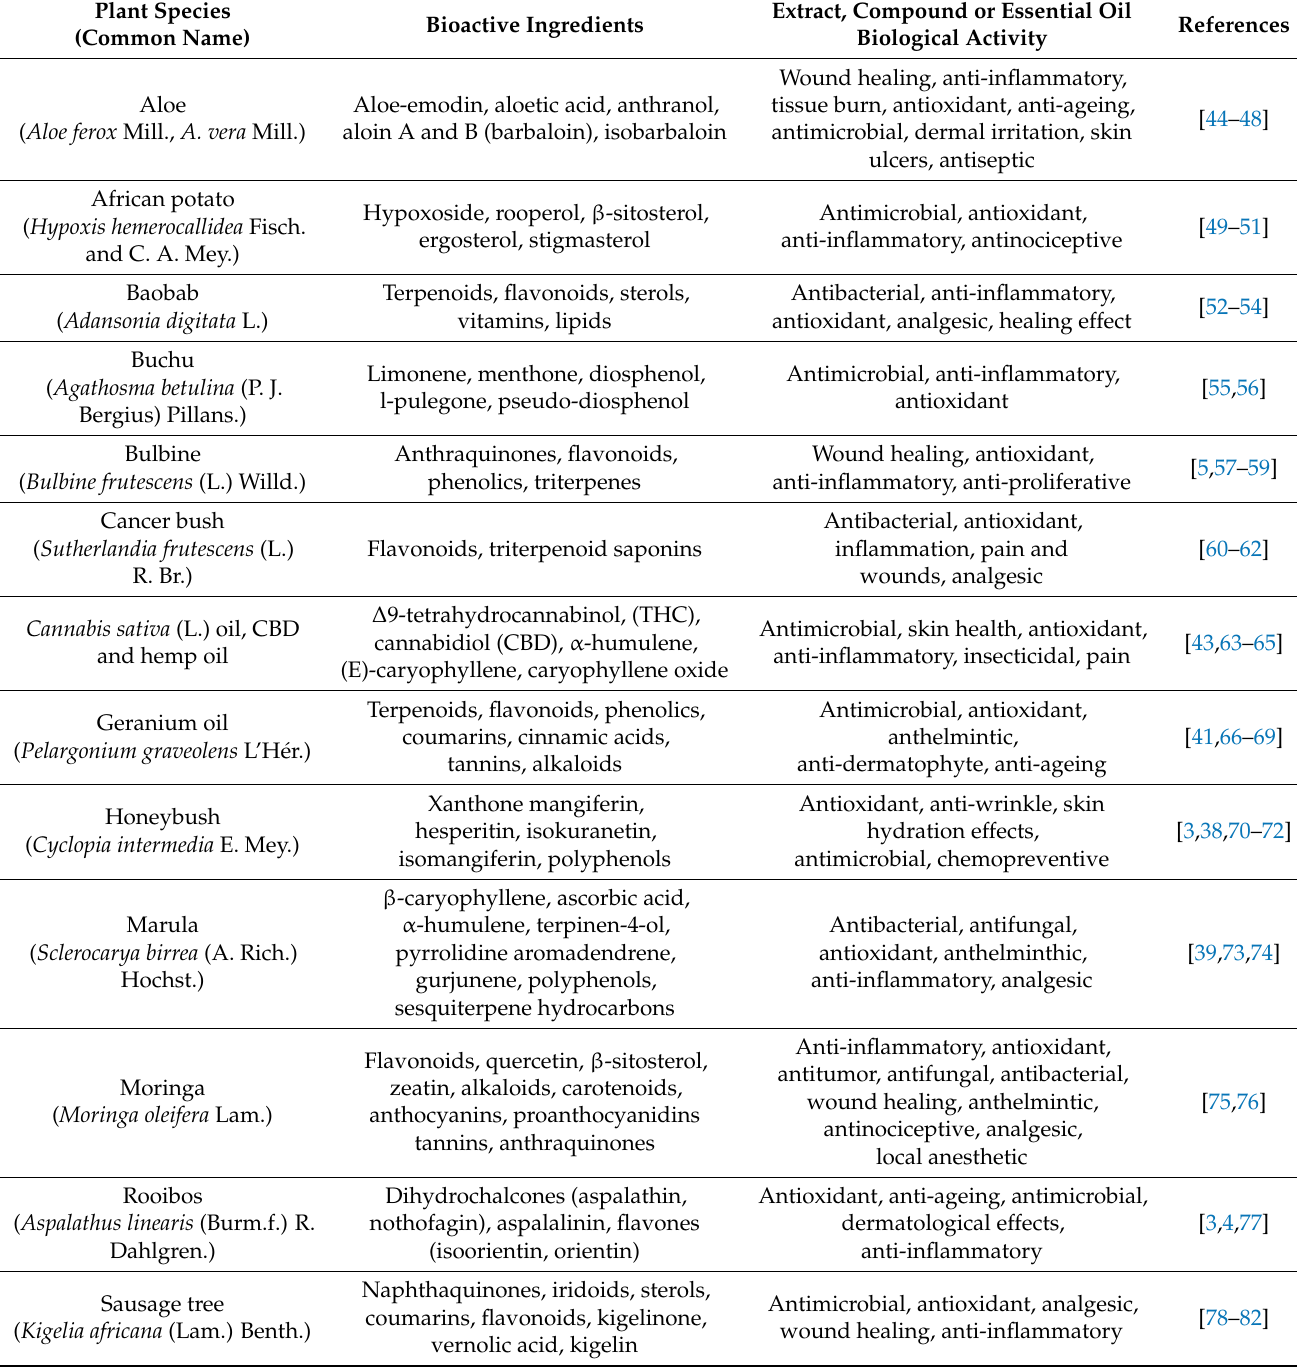
Table 3. Bioactive compounds and biological efficacy of medicinal plants used in product develop- ment (in reference to Tables 1 and